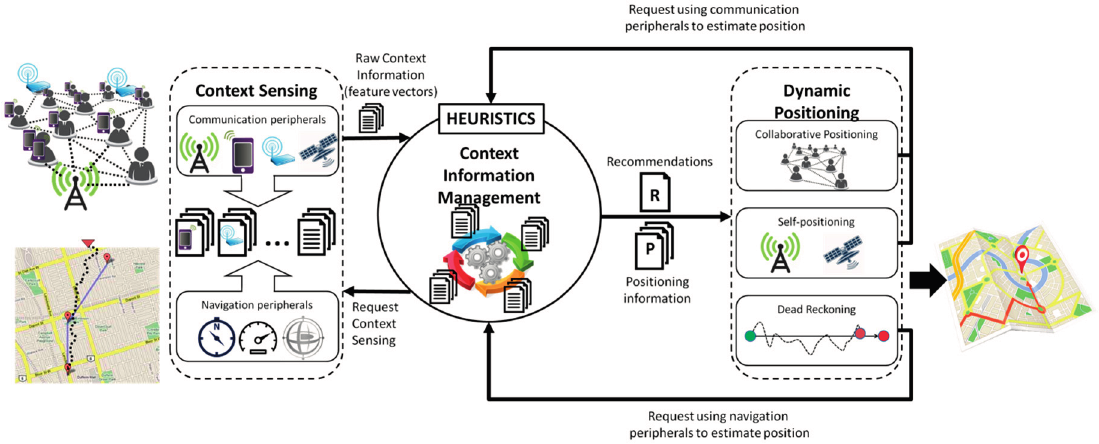
Figure 1. Three stage context-aware positioning